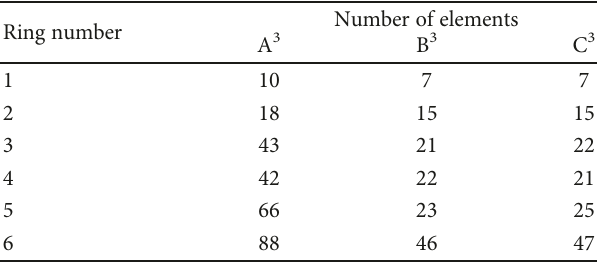
Table 8: The numbers of elements for individuals A 3 , B 3 , and C 3 . Ring number